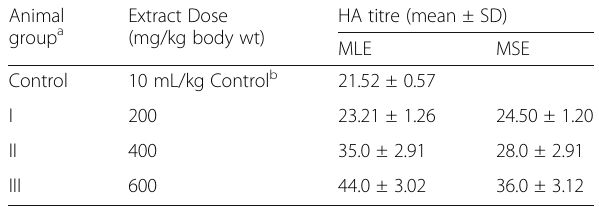
Table 6 Effect of methanolic leaf and stem extracts of B.